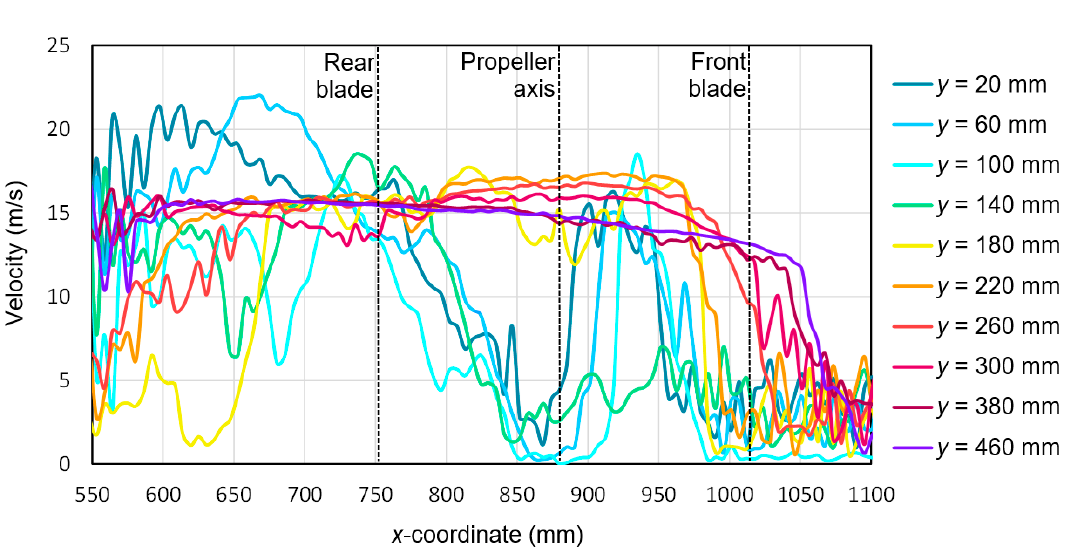
Figure 20. Resultant airflow velocities around the research object for the following configuration: angle of attack α = − 4° and airflow in the wind tunnel v wt = 12.5 m/s.